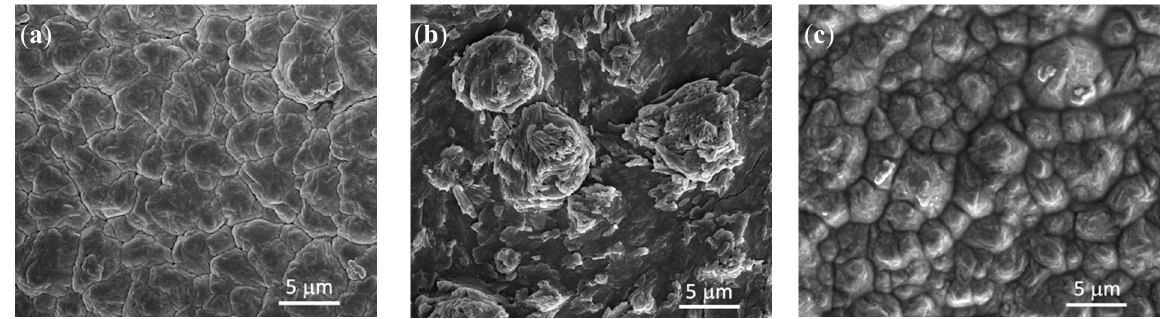
Figure 13. SEM images of Si 3 N 4 @Si@Cu anode material ( a ) before GCD, ( b ) after first discharge (lithiation) to 0.05 V vs. Li + /Li, and ( c ) after first GCD (lithiation/delithiation) to 1.20 V vs. Li + /Li.